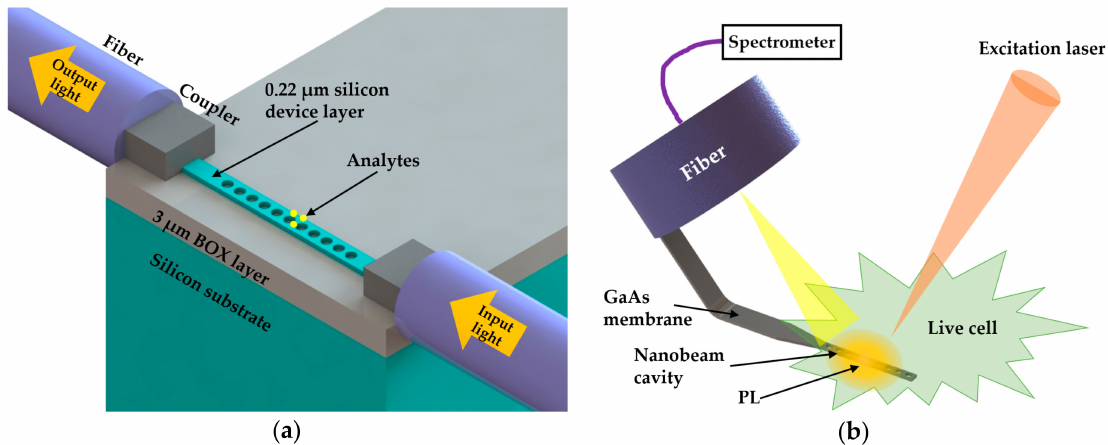
Figure 12. ( a ) Nanobeam cavity sensor for single streptavidin molecule; ( b ) nanobeam cavity sensor inside a live